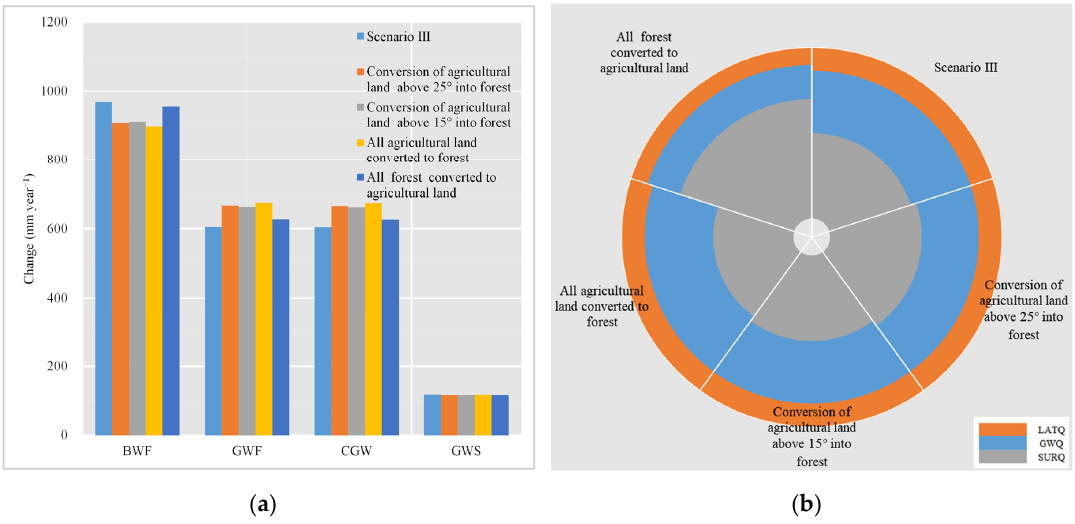
Figure 12. Simulation of the annual mean values ( a ) and proportions ( b ) of BWF, GWF, green water storage (GWS), and their components in the upper Ganjiang River basin by individually altered land-use factors based on Scenario III.